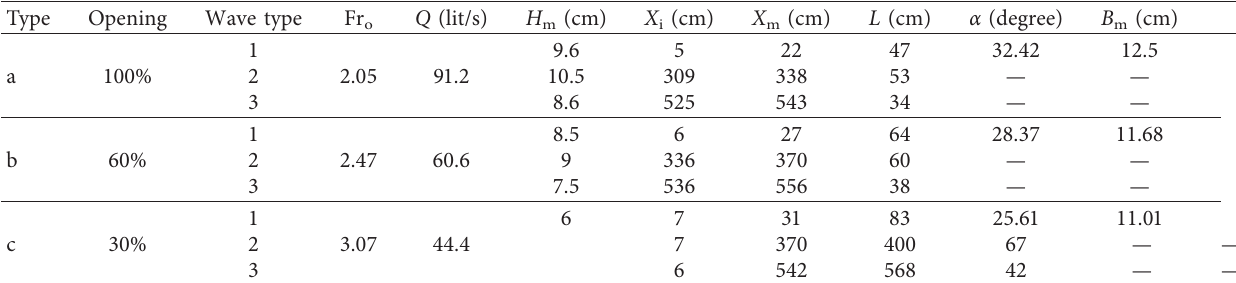
Figure 8: Longitudinal and transverse dimensionless profiles for the two middle gates’ performances: (a) wave 1 longitudinal profile, (b) wave 1 transverse profile, (c) wave 2 longitudinal profile, (d) wave 2 transverse profile, (e) wave 3 longitudinal profile, and (f) wave 3 transverse Table 1: The shockwaves’ flow characteristic for two middle gates’ operations.